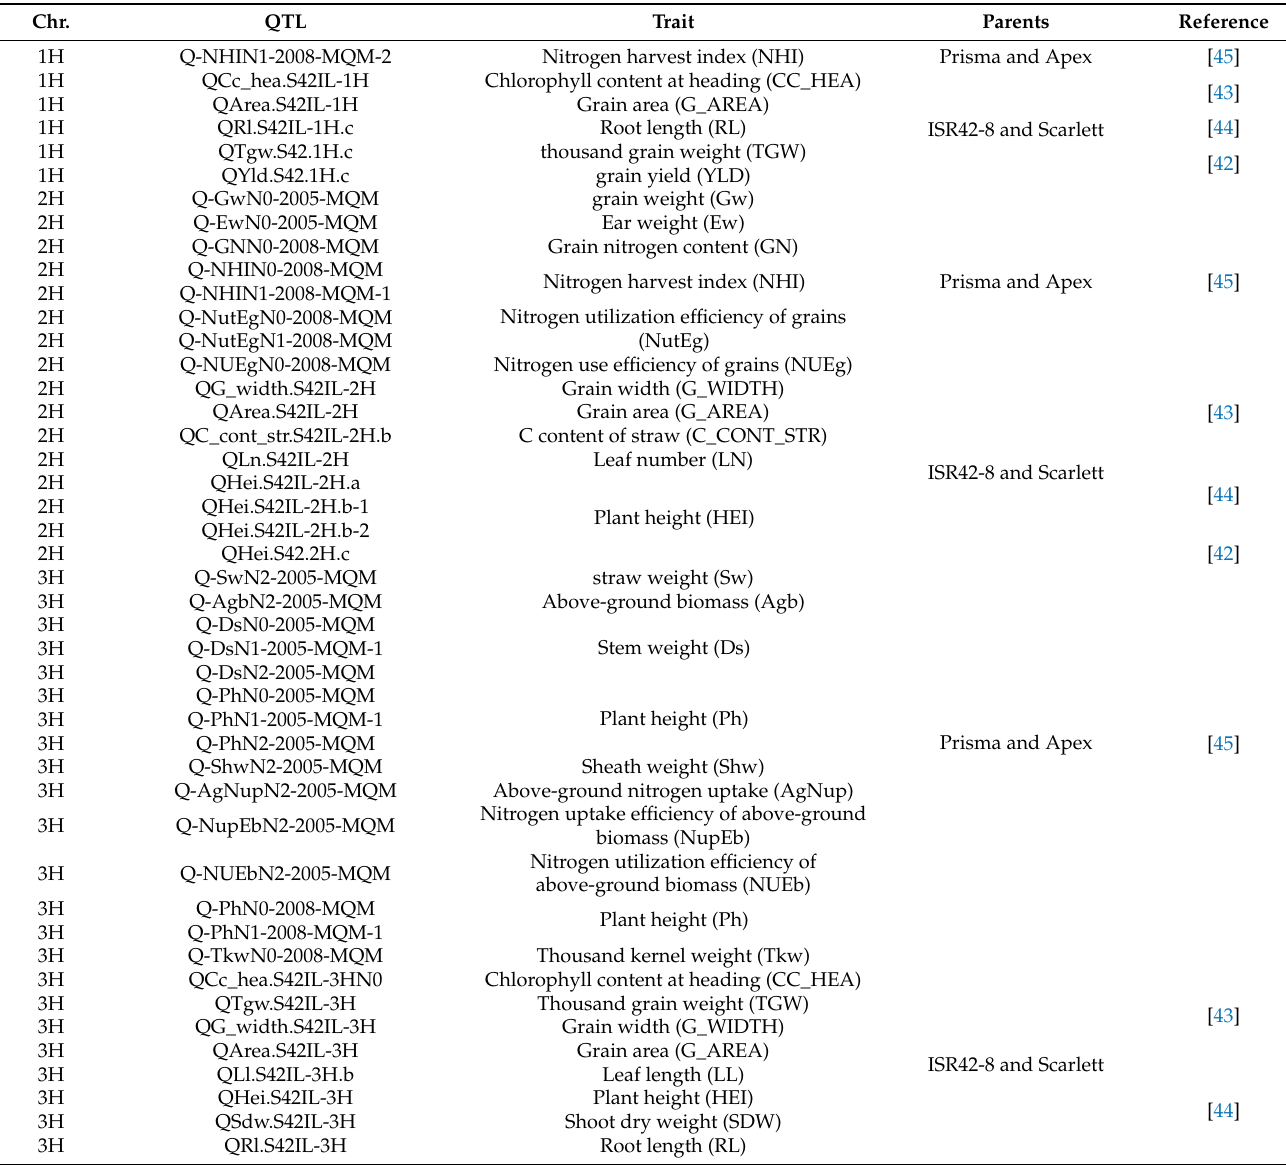
Table 1. Summary of potential QTL related to